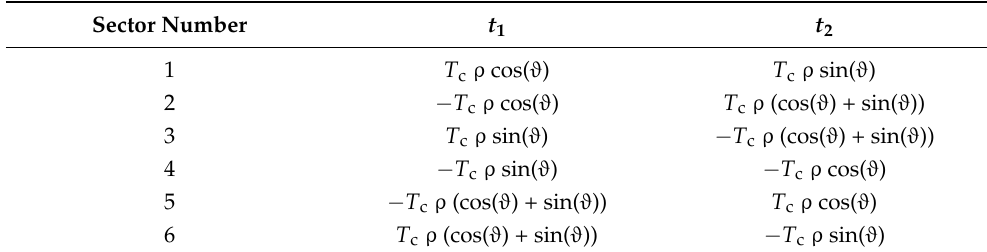
Table 2. Equations for t 1 and t 2 for every sector of two-level hexagon. ϑ is the angle, and ρ is the magnitude of U 0 vector in polar